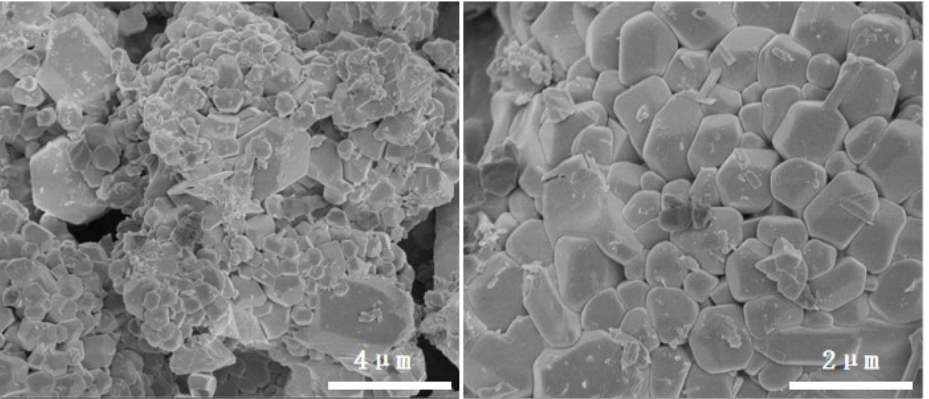
Figure 6. SEM micromorphology of cement